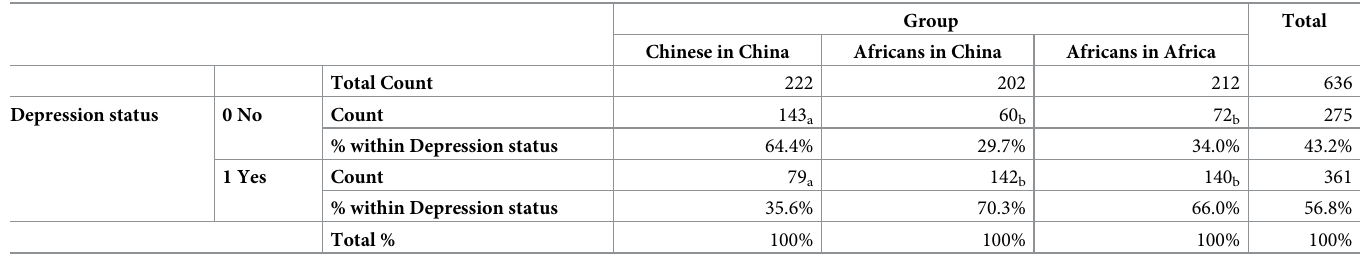
Table 2. Prevalence of depression.